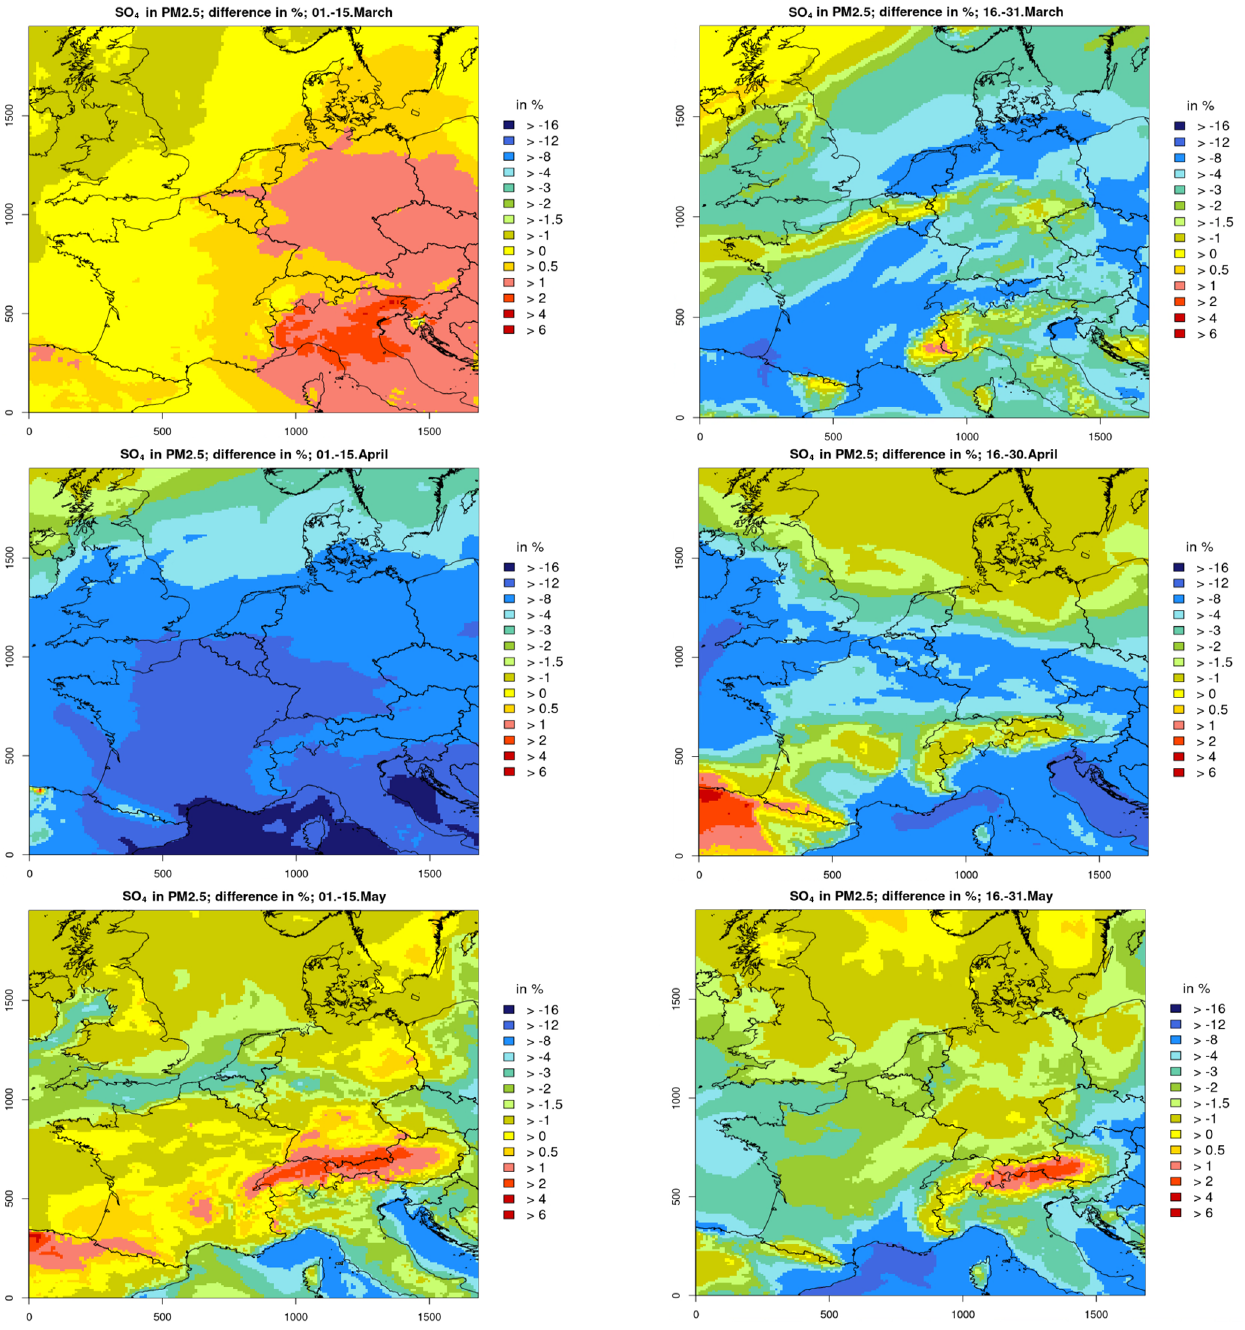
Figure A11. CMAQ results for relative particulate sulfate (SO 2 − ) concentration reductions due to lockdown measures (noCOV – COV run) 4 in central Europe between 1 March and 31 May 2020 in half-monthly intervals; positive values denote